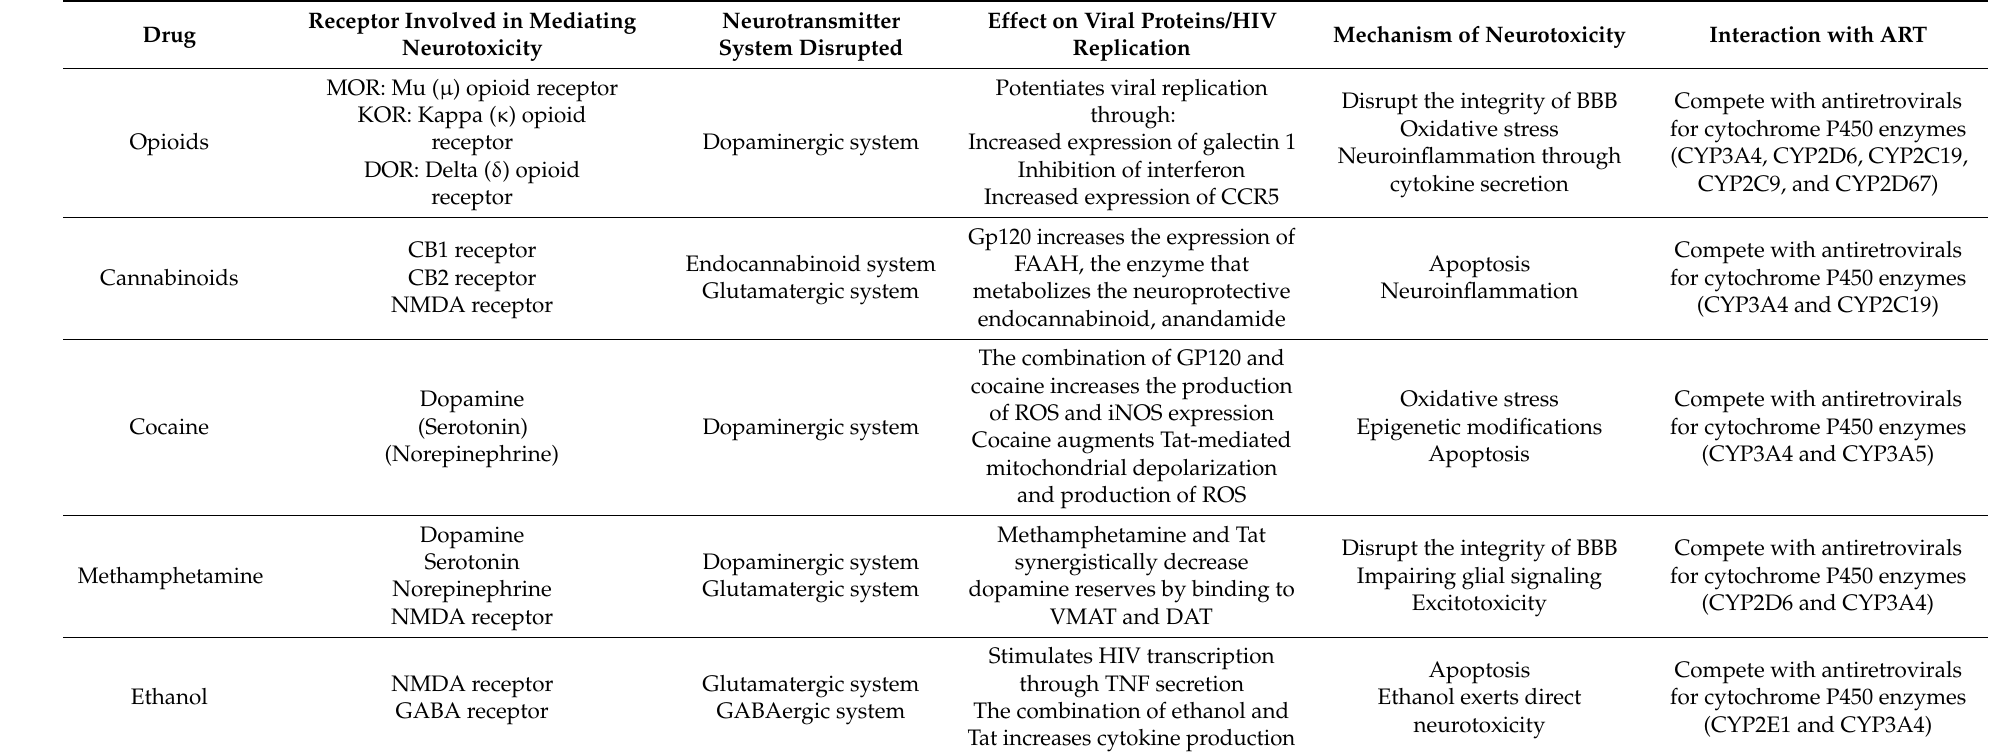
Table 1. Summary of similarities and differences between the mechanisms of neurotoxicity of major drugs of